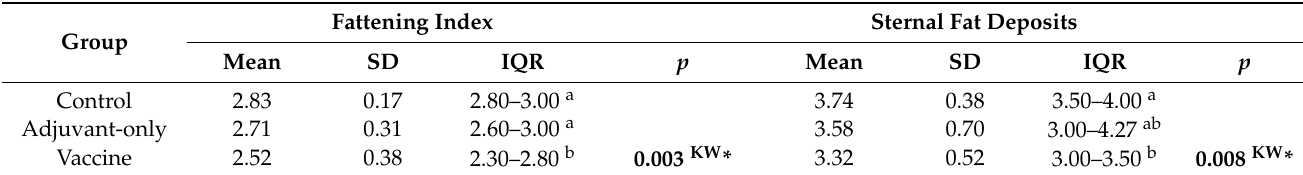
Table 2. Fattening index and sternal fat deposits in Control, Adjuvant-only, and Vaccine groups ( n = 26 each) when all flocks were considered together. Data represented as mean, standard deviation (SD), and interquartile rank (IQR). Fattening Index Sternal Fat Deposits Group